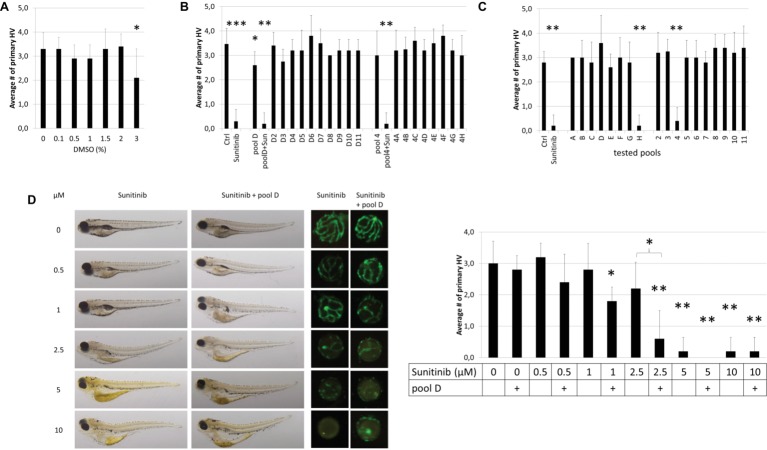
Proof-of-Principle. (A) Effect of DMSO concentration on HV assay. 1% DMSO vehicle has no effect on HV numbers. (B) The compounds of row D (D2-D11) and column 4 (4A-4H) in plate #30331 were tested individually and as pools. When 10 μM sunitinib was added to the pool “D” or “4” (pool D + Sun or pool4 + Sun), its antiangiogenic effects were as pronounced as if tested on its own (Sunitinib). (C) When compounds of plate #30251 were tested in pools, well H4 which was replaced with 10 μM sunitinib, was easily detected as antiangiogenic in both pools (“H” & “4”) containing H4. (D) A dose–response analysis with different concentrations of sunitinib alone or added to pool D in plate #30331 proves that weaker antiangiogenic effects can be reliably detected in pools. Shown are representative bright-field images of larvae, corresponding fluorescent images of dissected lenses and the quantification of primary hyaloid vessel numbers (right). Data shown are means ± SD. Statistical significance was calculated by t test and Mann Whitney test (*p < 0.05, **p < 0.01, *** p < 0.001).